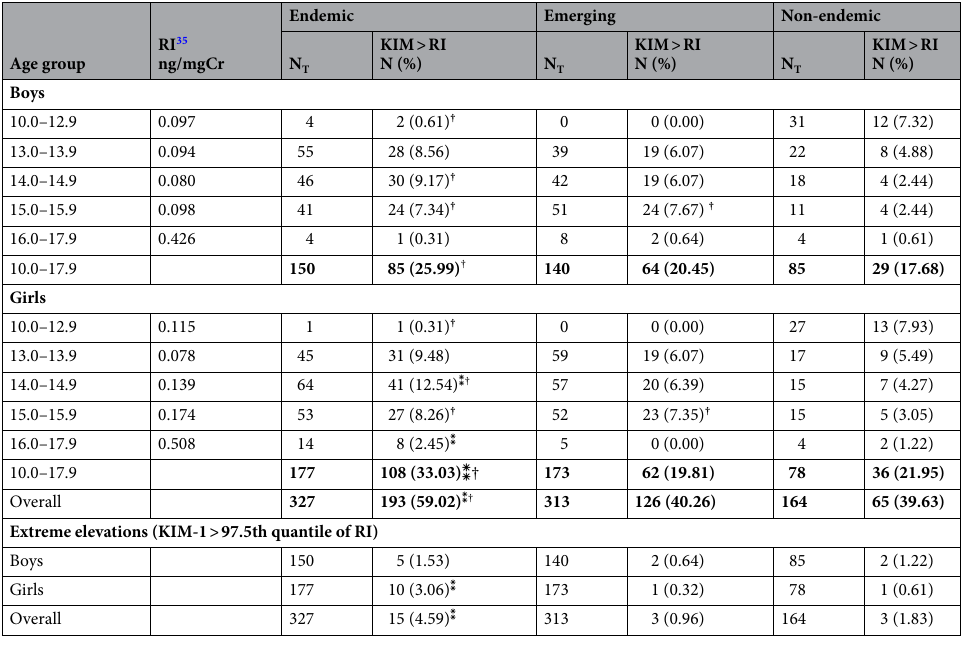
Table 3. The incidence of elevated expression of of urinary KIM-1 in children from CKDu endemic, emerging, and non-endemic regions in Sri Lanka. The reference interval and the median KIM-1 of each age stratum are given for each age group. The number of children in each age stratum with urinary KIM-1 levels above the RI (50th quantile at 90% CI) given in the previous study 35 , for that particular age group is given as N along with its percentage with respect to the total size of the respective study group, endemic, emerging, or non-endemic. Similarly, the number of children with urinary KIM-1 levels above the 97.5th quantile of RI are given as extreme elevations. Comparison of proportions of children above the RI is expressed according to Chi-squared test and for the age strata with (N < 20), Fisher’s exact test was used for comparison. ⁑ Denotes significance compared to the counterparts of same age in emerging group ( p < 0.05) and † denotes significance compared to the counterparts of same age in non-endemic group. RI reference intervals of biomarkers, N T total number of children in an age stratum within the study group, KIM-1: kidney injury